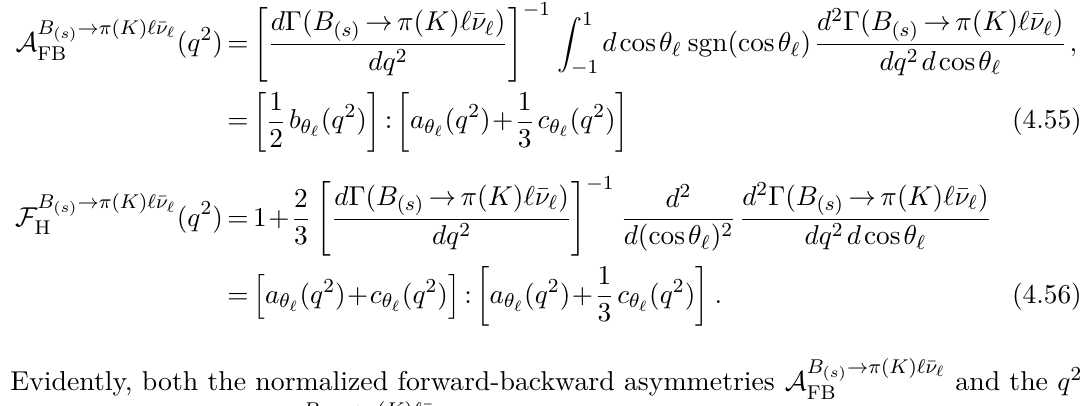
Figure 13 . Theory predictions for the two interesting LFU ratios R B → π ( K ) ‘ ¯ ν ‘ decay distributions obtained from the combined BCL expansion fitting against the ( s ) synthetic lattice data points and the newly obtained bottom-meson LCSR